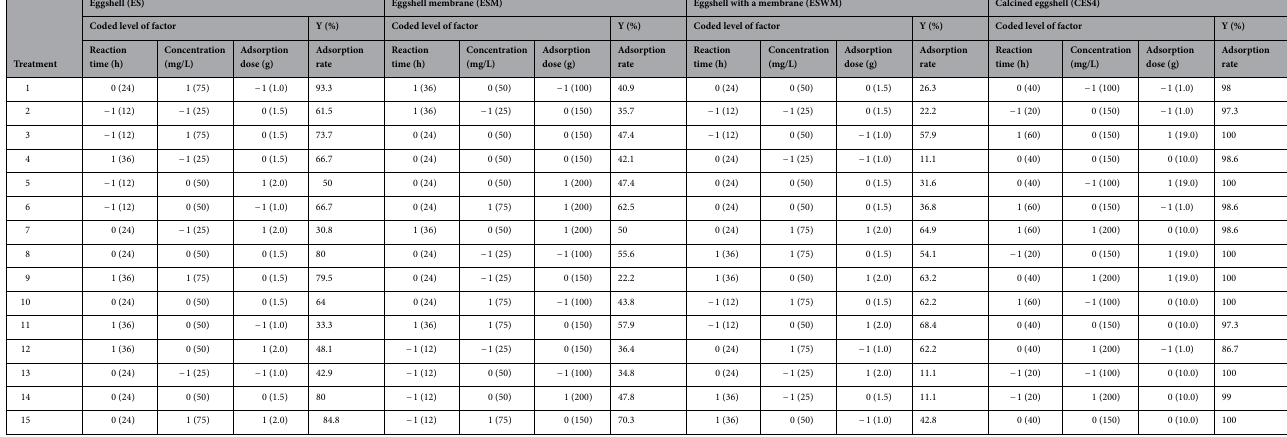
Table 2. Box–Behnken design (BBD) for adsorption rate of four different eggshells in 3-level-3-factor.